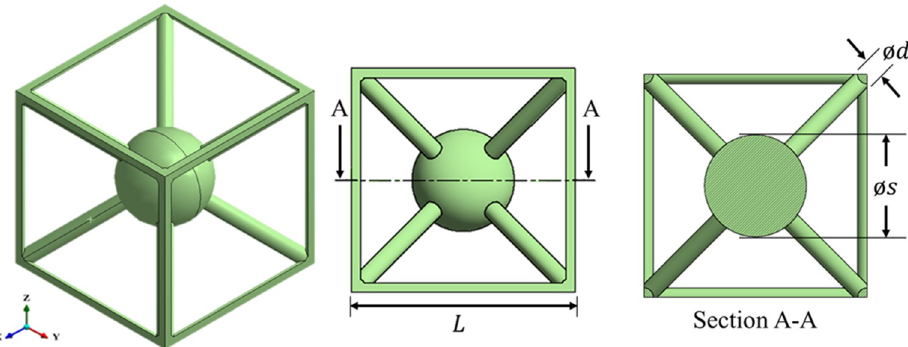
Figure 4. Res-BCC xyz unit cell as designed in CAD with strut diameter d , spherical mass of diameter s and cell size L .